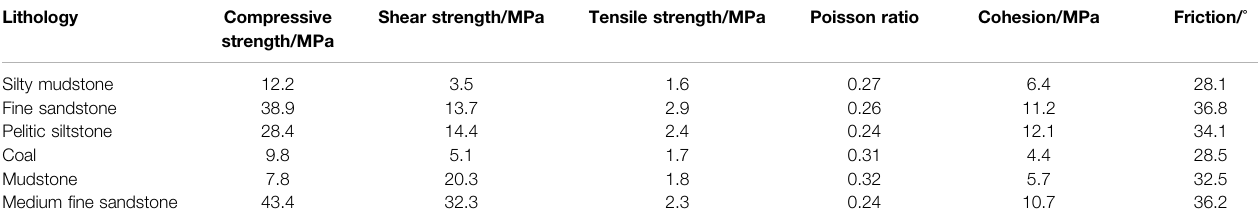
TABLE 1 | Measurement results of rock mechanical parameters.